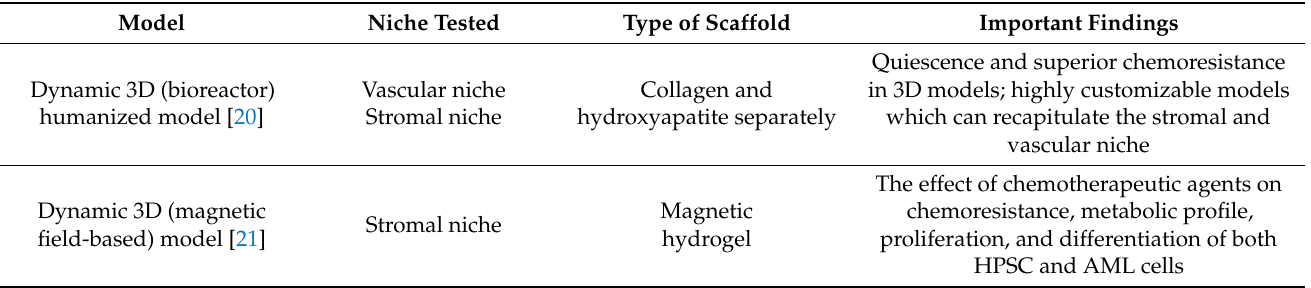
Table 3. Comparison between dynamic 3D in vitro